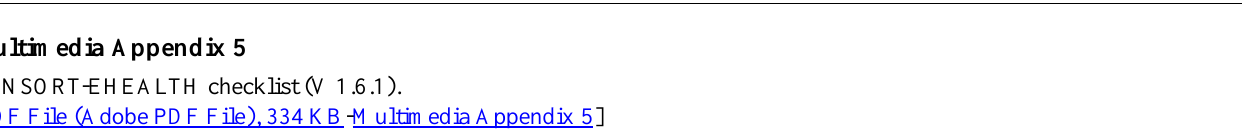
Table S3. Inter-rater agreement for DWI-ASPECTS ≥ 7 or DWI-ASPECTS <7 for desktop PC monitor in VN1 vs smartphone monitor in VN2.